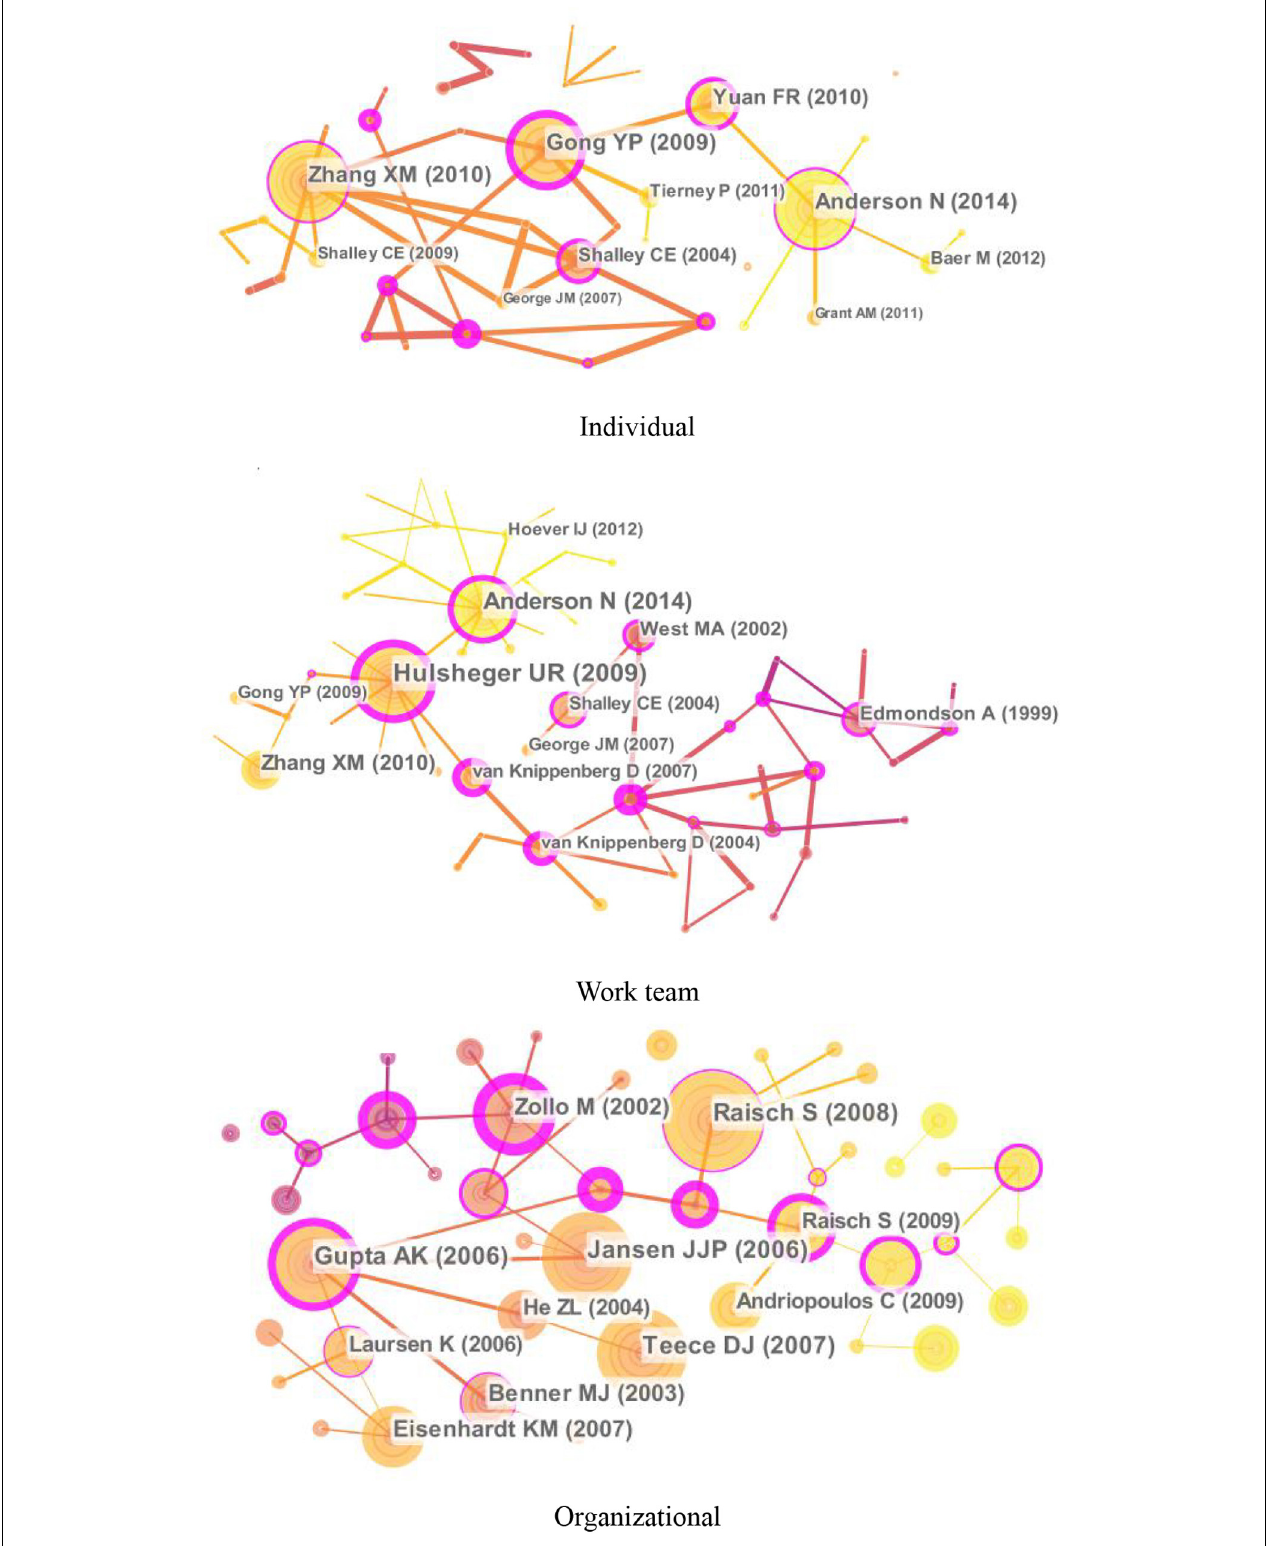
FIGURE 5 | Knowledge maps of the cited references of innovation research at different levels.